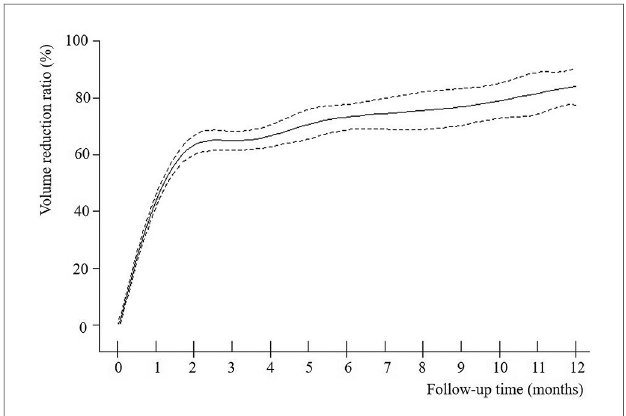
FIGURE 2 VRR-Time fi tting curve for “ BTN ” group. BTN, benign thyroid nodule; VRR, volume reduction ratio.